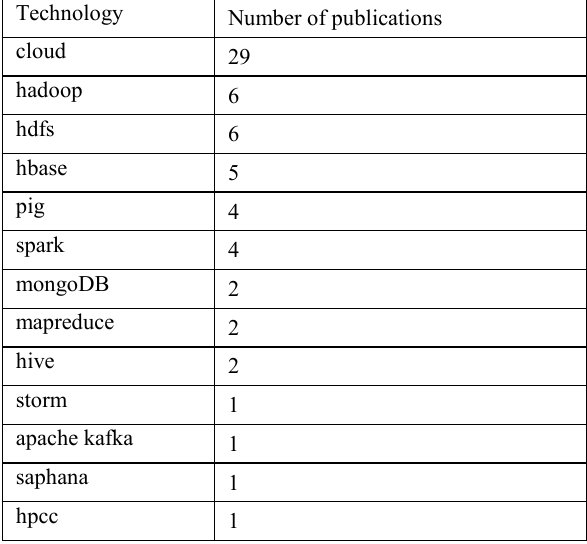
Table 7: Number of publications per Big Data Technology used in real time remote sensing studies